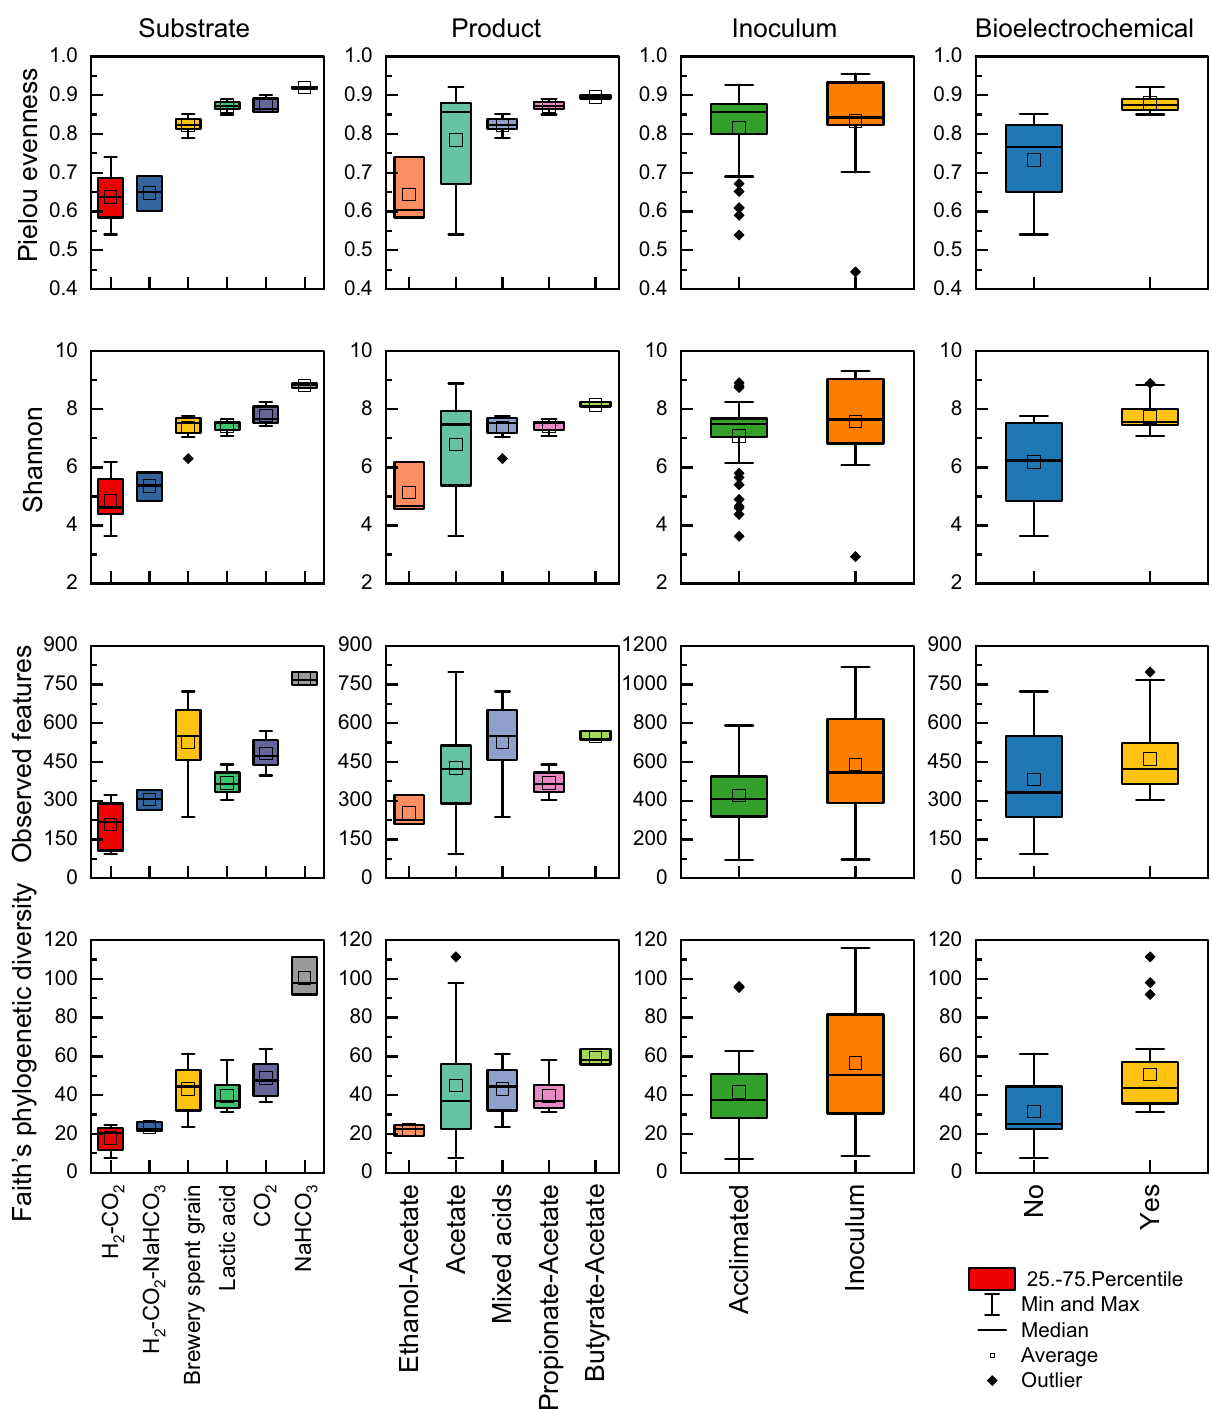
Fig. 5 Alpha diversity indexes (Pielou evenness, Shannon, observed features, and Faith ’ s phylogenetic diversity) of acidogenic samples grouped by substrate, product, inoculum, and bioelectrochemical characteristic. The line and square in the box mark the mid-point and average values of the data, respectively. The upper and lower edges of the box mark that the seventy- fi ve and twenty- fi ve of the data fall below the upper quartile and the lower quartile, respectively. The upper and lower whiskers represent the maximum and minimum values respectively, excluding outliers. The black diamond represents the features accounted for 4.9 – 66.1% of the fermentation-pathway genes (Supplementary Fig. 6b), with an average of 27.0% per pathway. This result implies that the core features participated not only in the top 40 pathways, but also in the 15 fermentation pathways in the acidogenic samples.